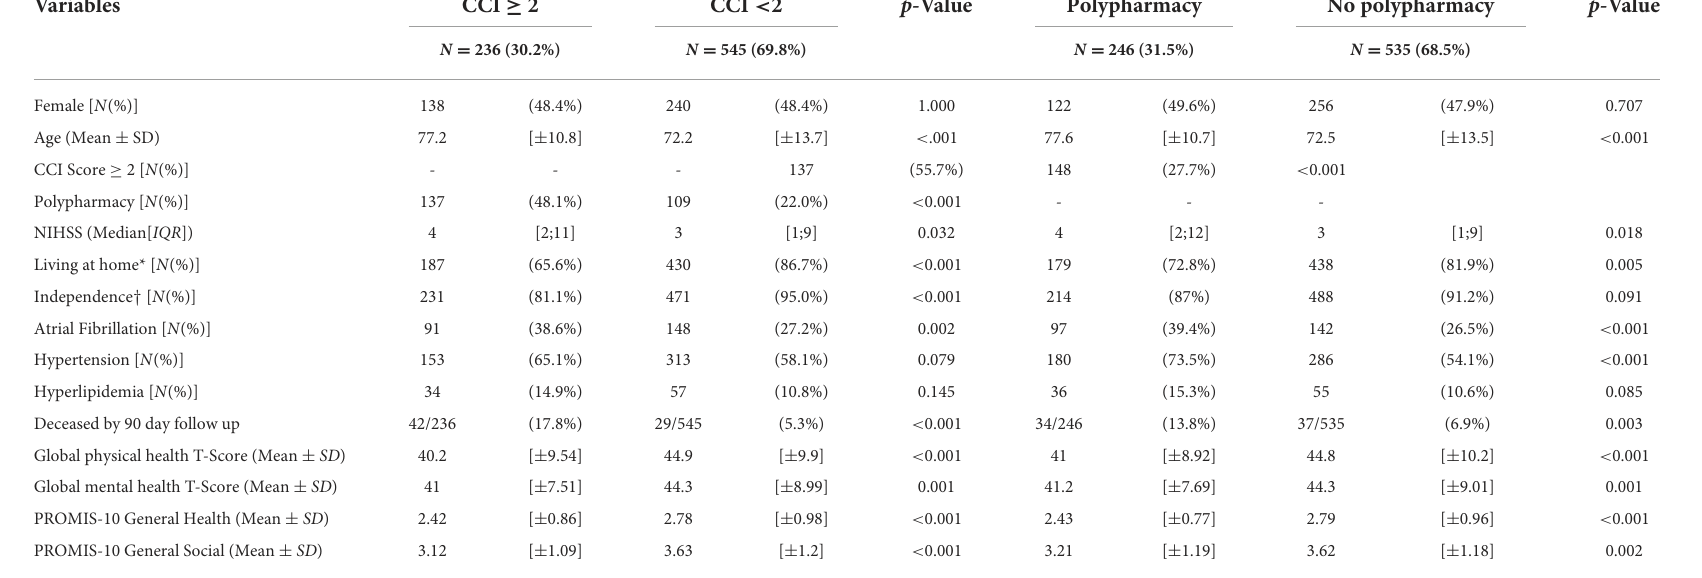
TABLE 2 Patient characteristics at baseline compared between patients with/without CCI > 2 and with/without polypharmacy.